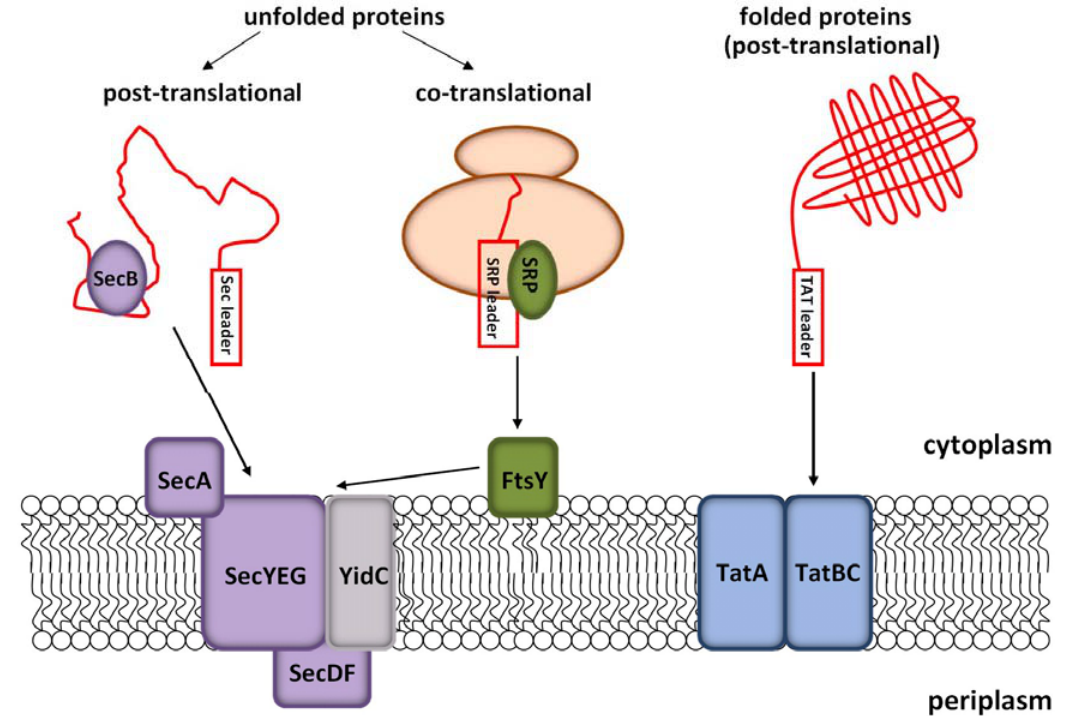
Figure 2. Schematic representation of the three major secretion pathways in E.